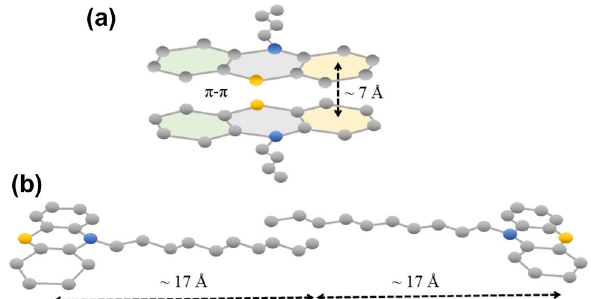
Figure 4. Scheme of a possible arrangement of molecules in PTZ-C4 ( a ) and PTZ-C10 ( b